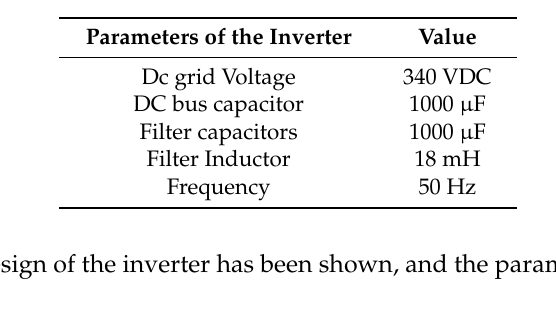
Table 1. Inverter parameters used in the simulation.